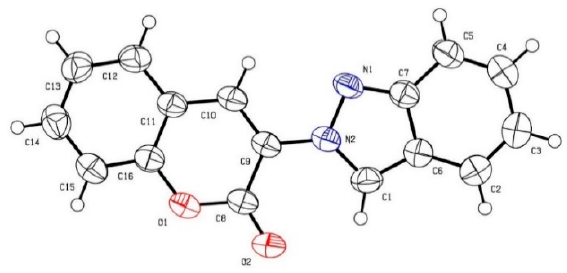
Figure 2. ORTEP plot of the crystallographic data for 6 . Table 2. Fluorescence Properties a .